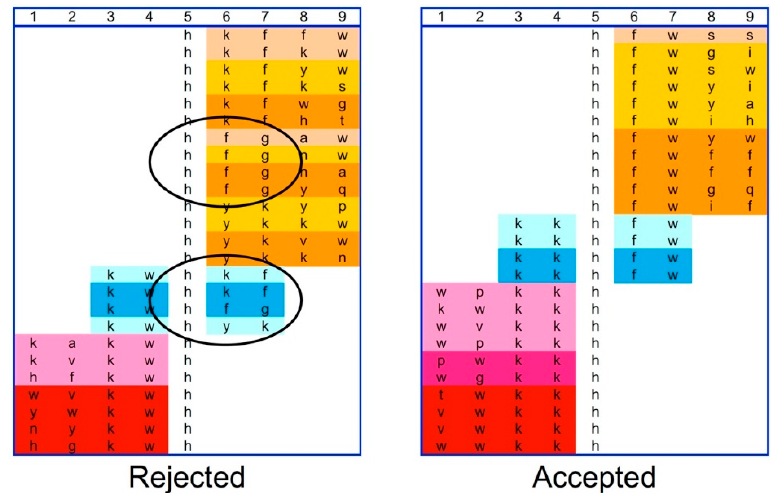
Figure 5. Illustration of the process of rejecting and accepting complementary peptide sequences to C-peptide. In the left table, the pink and red libraries, as well as the light and dark blue libraries, possess kw (positions 3 and 4) in each coloured library and in two di ff erent rounds (e.g., pink and red), so they fulfil the two criteria for acceptance. However, positions 6 and 7 fail one or both criteria (lower oval). For example, kf may appear in two di ff erent rounds (Criterion 1), but it only appears once in each round. Both fg and yk only appear once in either round. Thus, even though fg fulfils both criteria in the orange / dark yellow / cream library (upper oval), this whole table is rejected because positions 1–5 cannot link up with positions 5–9. On the other hand, all sectors in the right table fulfil both criteria of acceptance, so the self-consistent table on the right is accepted.